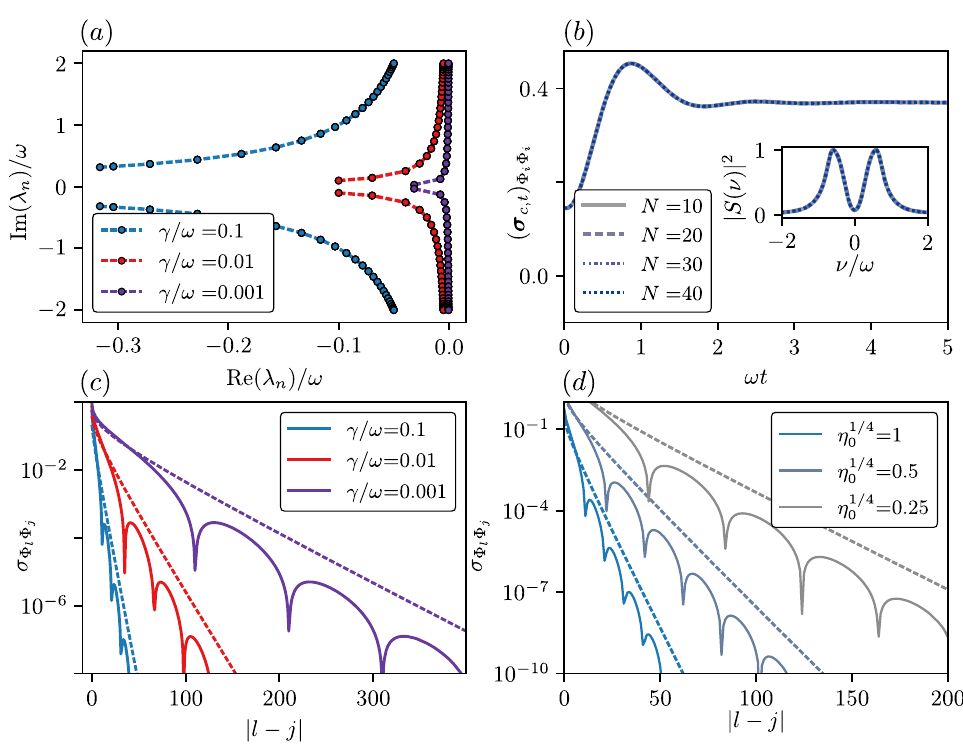
Figure 2: (a) Riccati spectrum R for Φ -field measurements and for different Ricc, N measurement strengths γ . Markers correspond to results obtained from a numerical = 1; the dashed lines corre- diagonalization of Eq. (30) with finite N = 30 and η 0 spond to the analytical result from Eq. (45). The predominant feature is an emerging gap in the imaginary part of the eigenvalues corresponding to the measurement- induced mass. (b) Numerical simulation of the conditioned dynamics of the field = 0.9 for different fluctuations at i = N / 2 after a mass quench r = Ω /ω = 10 and η 0 system sizes N . The inset shows the power spectrum for different system sizes N , where a trivial ∼ δ ( ν ) has been omitted. (c) Steady state real space field correla- = 1 and N = 1000 with periodic boundary conditions for different tions σ Φ for η Φ 0 l j measurement strengths γ . The solid lines correspond to exact numerical results ob- tained from the solution of Eq. (23). The dashed lines correspond to the approximate analytical result of Eq. (48). (d) Real space correlations σ Φ under measurement Φ l j imperfections for γ/ω = 0.1 (blue line in (c)) and different η . Solid (dashed) lines 0 corresponds to exact (approximate)